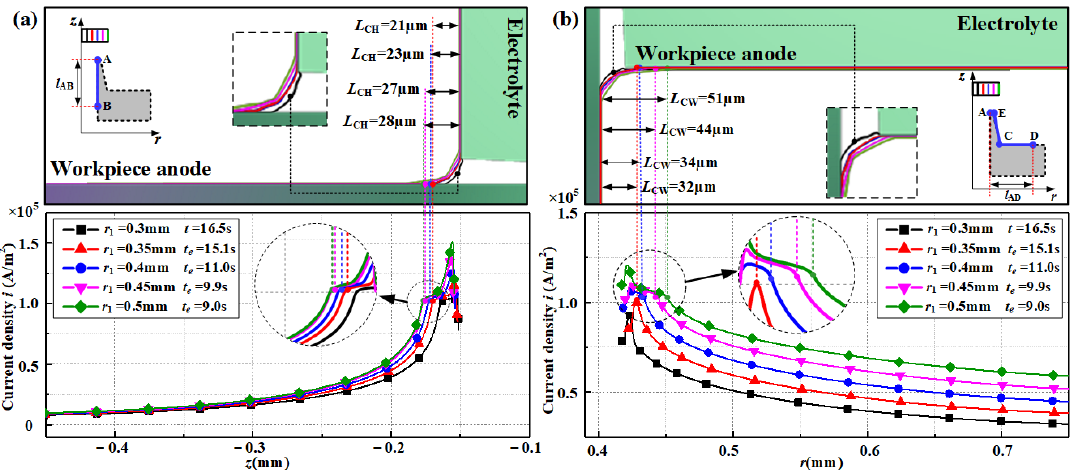
Figure 12. Influence of electrode radius: ( a ) Current density distribution of l AB ; ( b ) Current density distribution of l AD .